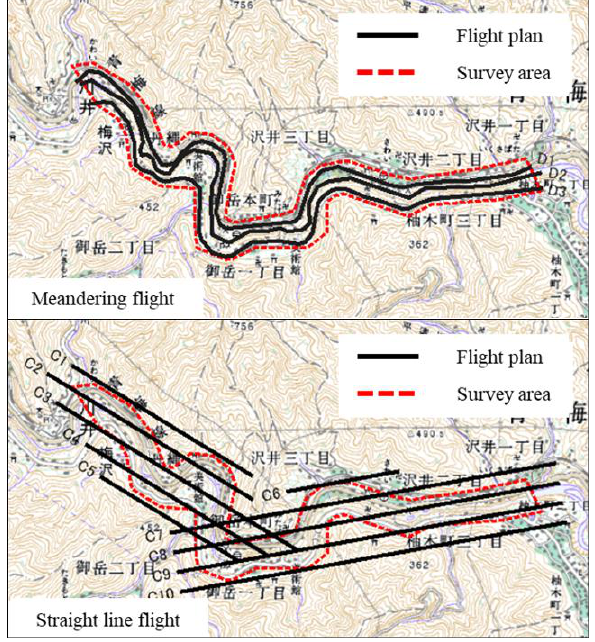
Figure 3. Flight plan of the preliminary experiment